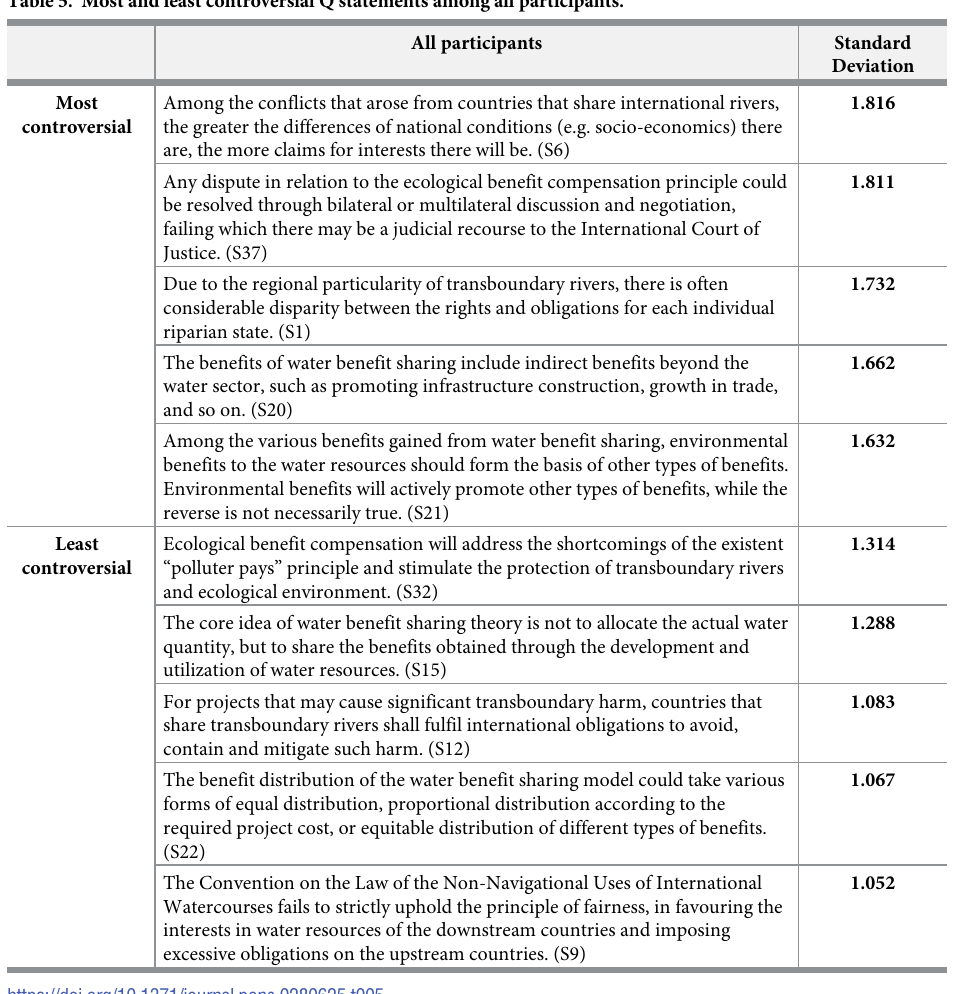
Table 5. Most and least controversial Q statements among all